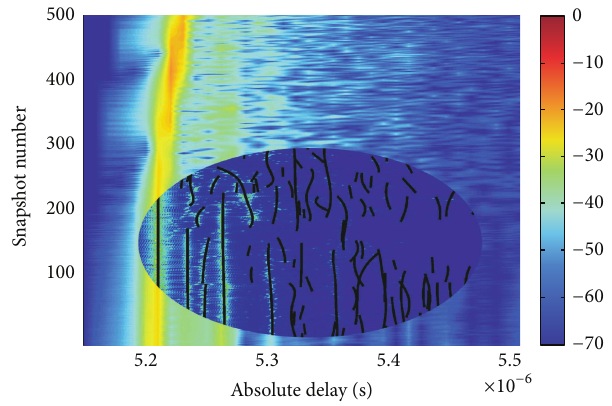
Figure 7: Series of 500 CIR snapshots recorded in the urban city center environment for car applications. Background: 100 MHz interpolated measured CIR sequence; elliptic detail: 500 MHz inter- polated ESPRIT result; black lines: detected echo signal delay evolutions (see Section